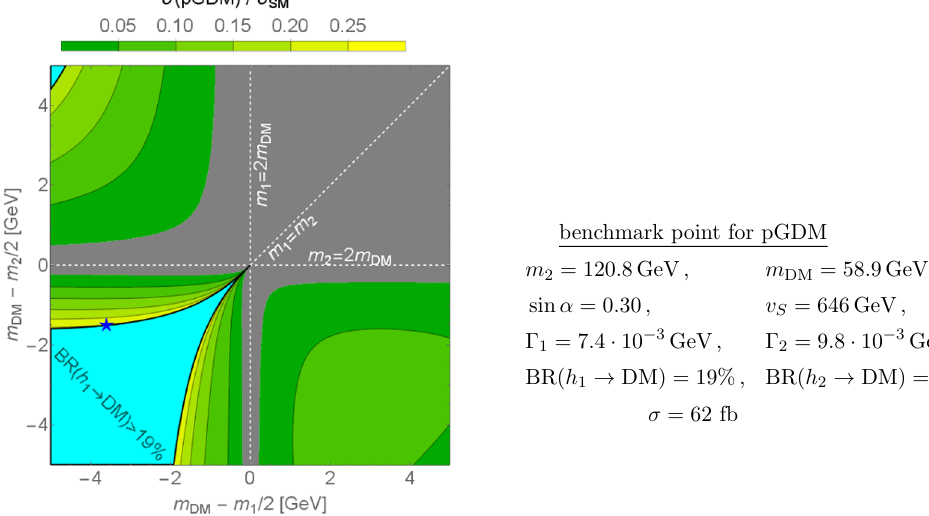
Figure 9 . The (cid:12)gure shows, for the pGDM, the allowed region (greenish), the region forbidden by the invisible BR of h 1 (cyan) where BR( h 1 ! DM) > 19% and the gray region where the normalized cross section falls below its expected precision at the 95% CL shown in (cid:12)gure 8. Coloring of the greenish area, explained in the legend, shows the value of the normalized total cross section (cid:27)=(cid:27) SM . The star denotes the chosen benchmark point, characterized by relatively high cross